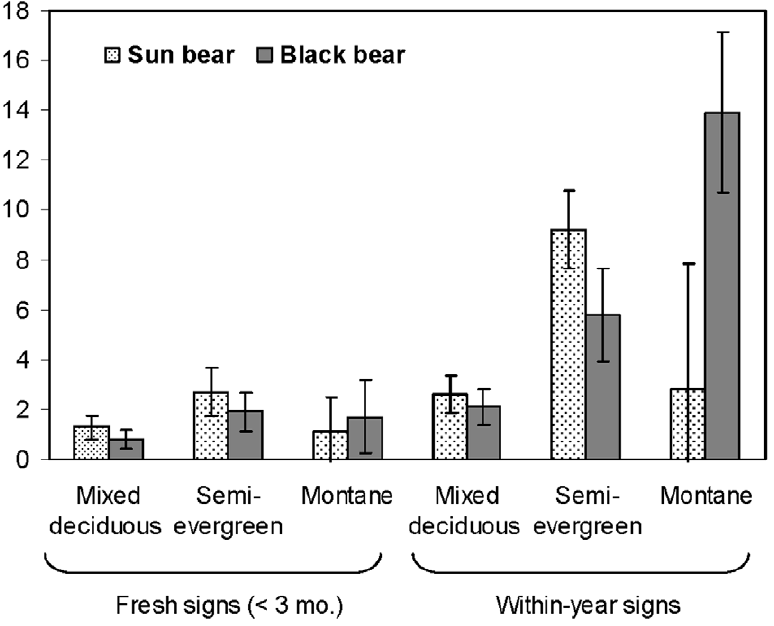
Figure 3. Sign density ( (cid:2) xx and 90% CIs) of sun bears and black bears in three habitats of Thung Yai Naresuan Wildlife Sanctuary, Thailand, 2001–2003. Fresh signs ( , 3 months) are a subset of within-year